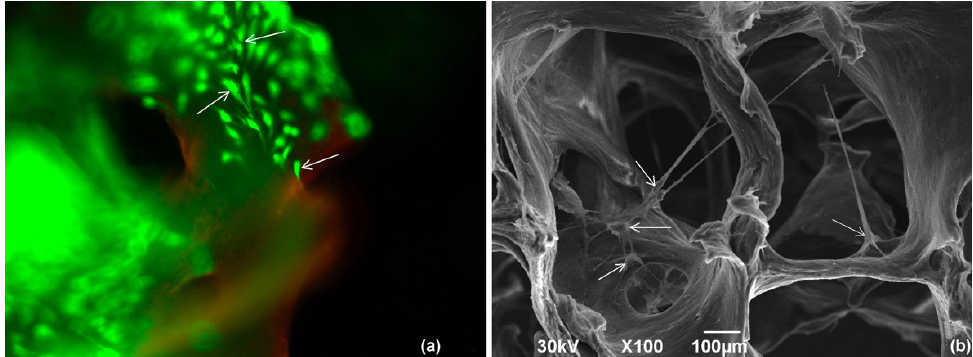
Figure 7. Demineralized spongiosa using the Lyoplast ® technology with populated chondroblasts: ( a ) populated viable chondroblasts on the surface of the biocarrier (arrows indicate attached cells). Live/Dead ® fluorophore staining. Fluorescence microscopy, ×100; ( b ) cells inhabiting the surface of trabeculae are marked by arrows. SEM, ×100.